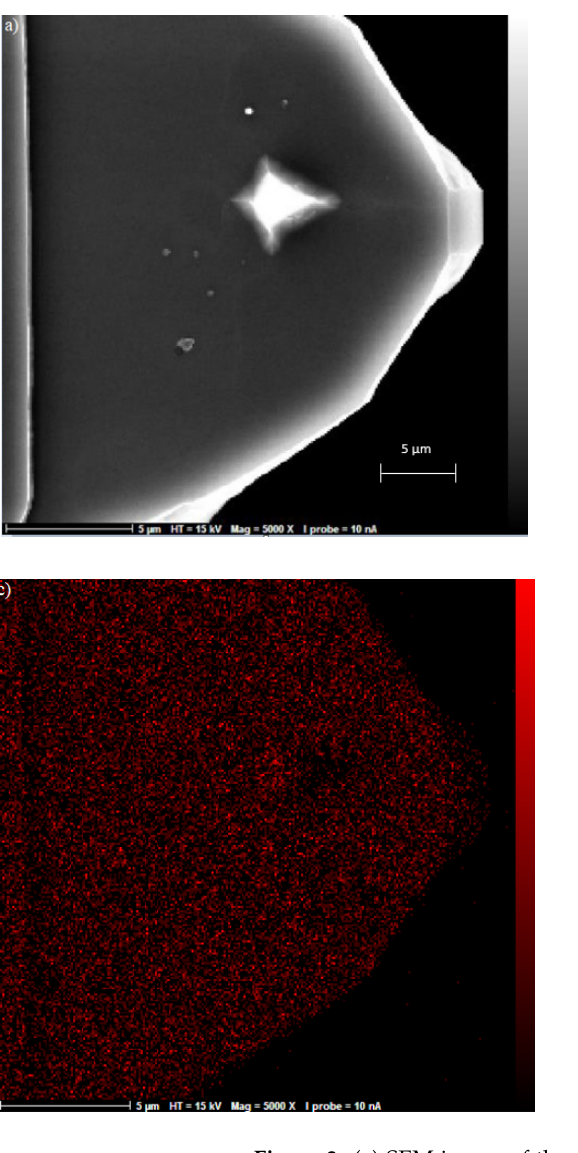
Figure 3. ( a ) SEM image of the cantilever tip with the scale of 5 μ m; ( b ) EDX image showing the dispersion of Si on cantilever; ( c ) EDX image showing the dispersion of 90.18% gold and ( d ) dis ‐ persion of both gold and Si on the cantilever tip. of both gold and Si on the cantilever